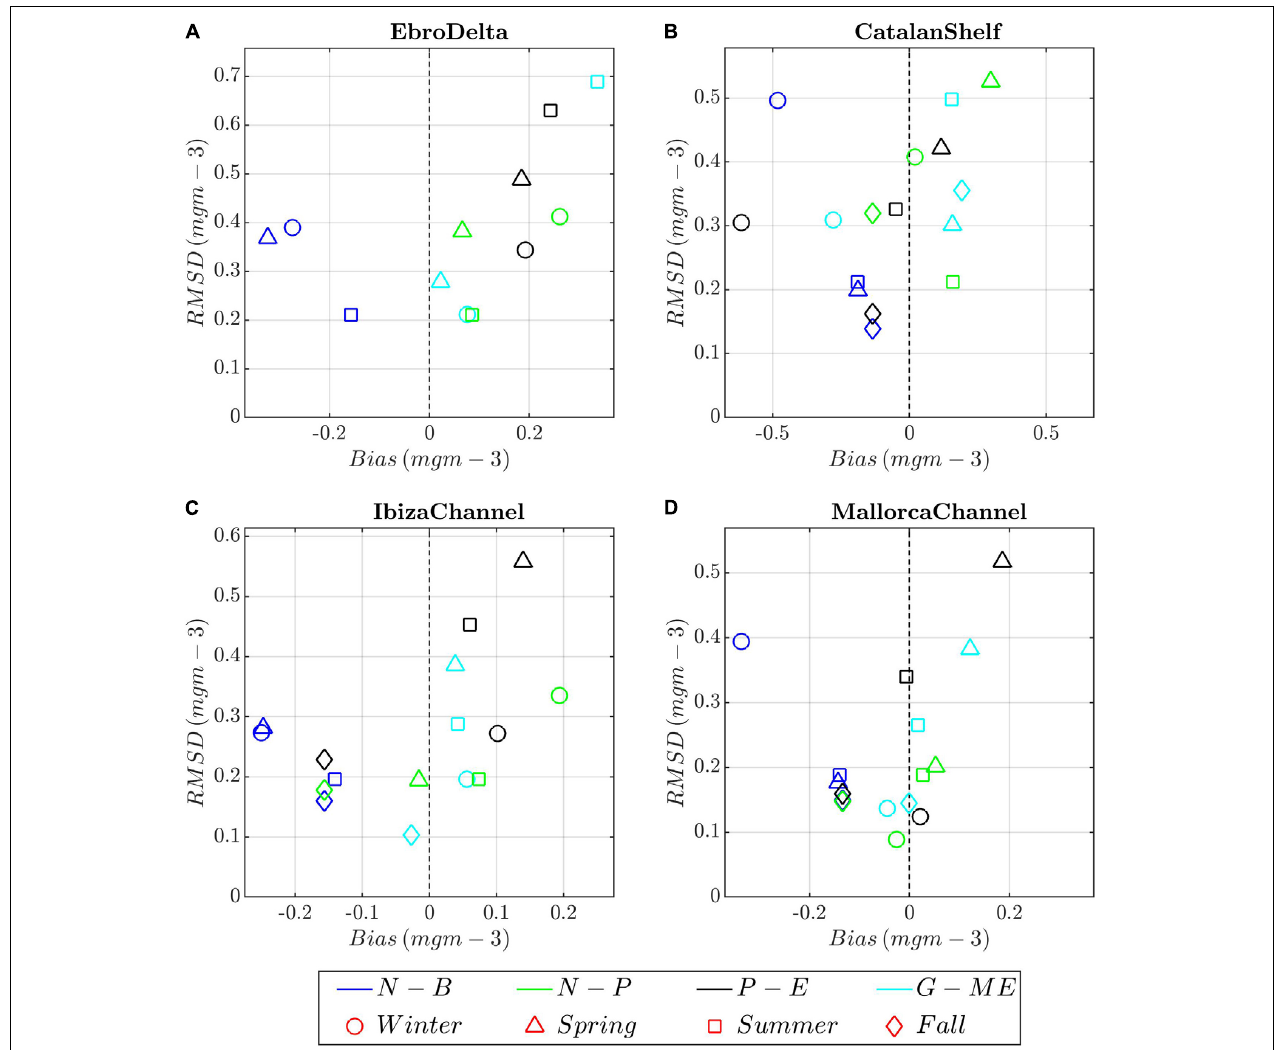
FIGURE 12 | Target diagrams between model runs (color shading) and chlorophyll- a climatological profiles for the different seasons (symbols) and areas. (A) Ebro Delta; (B) Catalan Shelf, (C) Ibiza Channel, and (D) Mallorca Channel. Model runs: blue, N-B (NEMO-BFM); green, N-P (NEMO-PISCES), dark gray; P-E (POLCOMS-ERSEM), and light blue, G-E